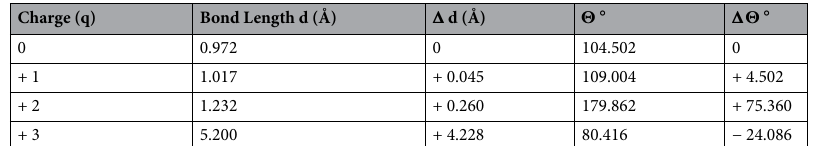
Table 2. The effect of electron removal in the bond length of H 2 O molecule. The charge state (q) refers to the number of electron removed from the neutral system. Charge q = 1 refers to 1.60217662 × 10 molecule. The H-O-H bond angle is also provided.